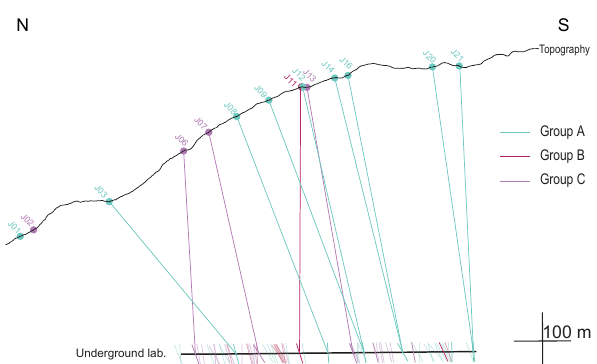
Figure 10. Cross section showing maximum a posteriori connec- tions between surface and underground faults. Faults are grouped and coloured according to their strike. Underground faults are rep- resented by short ticks; the less transparent ones have a connection to the surface.